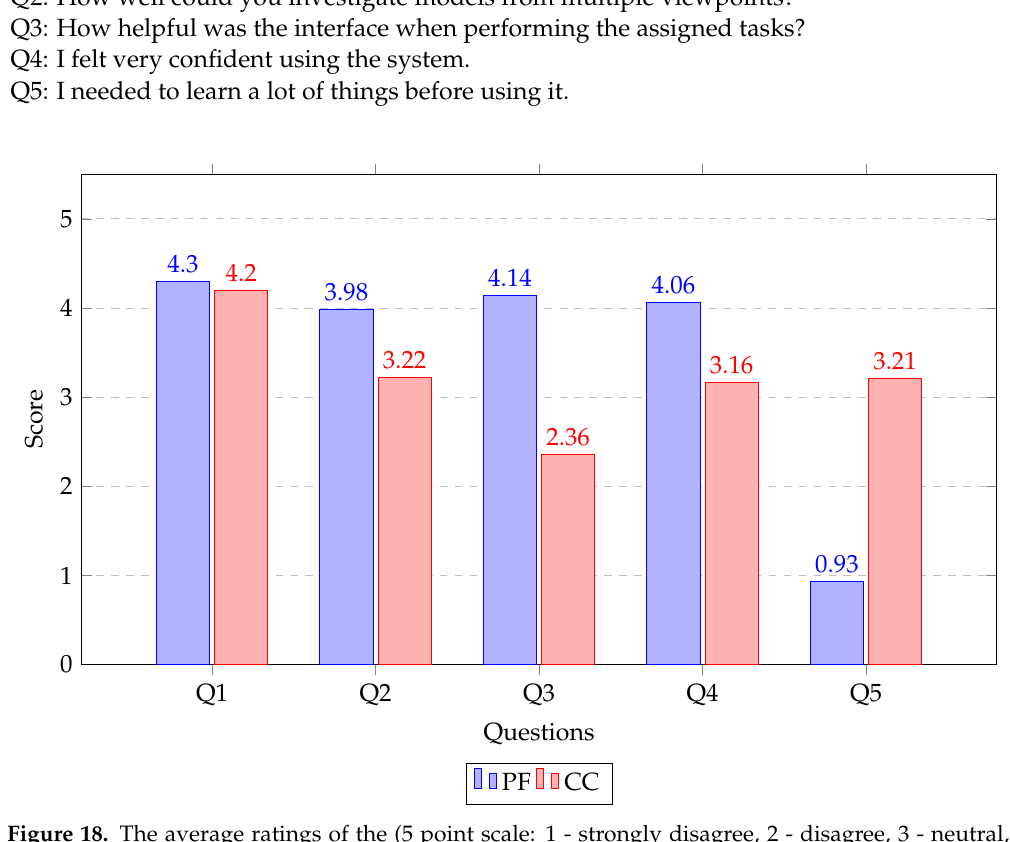
Figure 18. The average ratings of the (5 point scale: 1 - strongly disagree, 2 - disagree, 3 - neutral, 4 - agree, 5 - strongly agree) user satisfaction questionnaire for Proposed Framework (PF) and CloudCompare